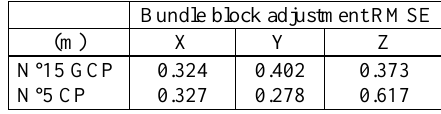
Table 1. RMSE on measured GCP and CP